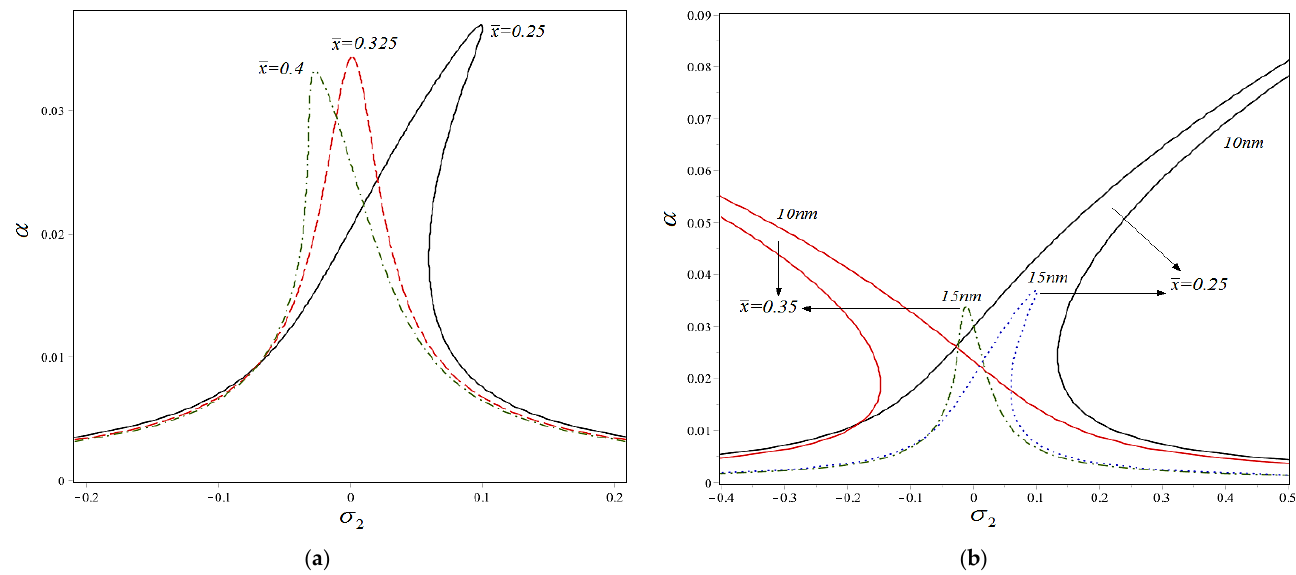
Figure 8. ( a ) Cubic curve shape effect on the frequency response of the primary resonance; ( b ) piezoelectric thickness effect on the response of the cubic curve primary resonance.